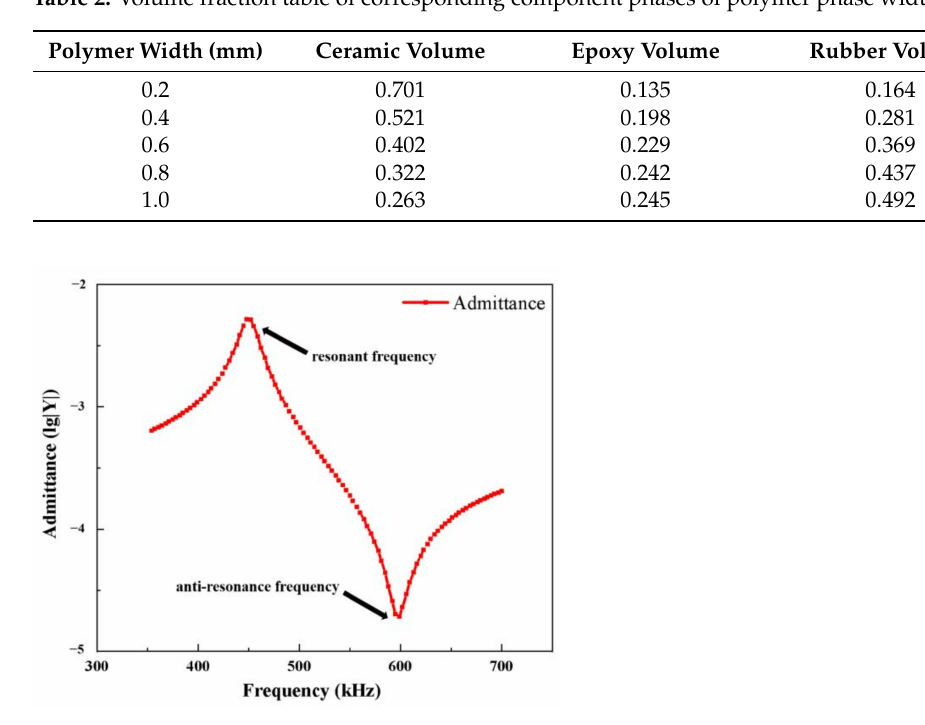
Table 2. Volume fraction table of corresponding component phases of polymer phase width.